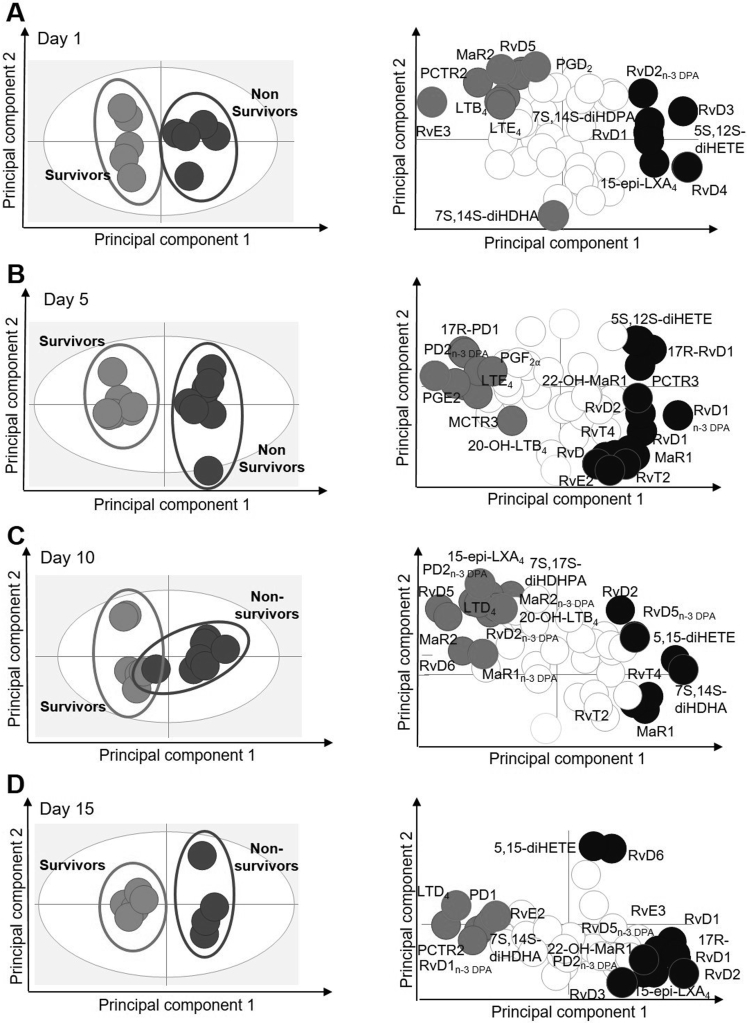
(A–C) Two-dimensional score plot (left) and loading plot (right) of samples at day 1 (A), day 5 (B), day 10 (C), and day 15 (D). Gray ellipse in the score plot denotes 95% confidence interval regions. Day 1: survivors n = 5, non-survivors n = 5; day 10: survivors n = 6, non-survivors n = 7; day 15: survivors n = 5, non-survivors = 4.